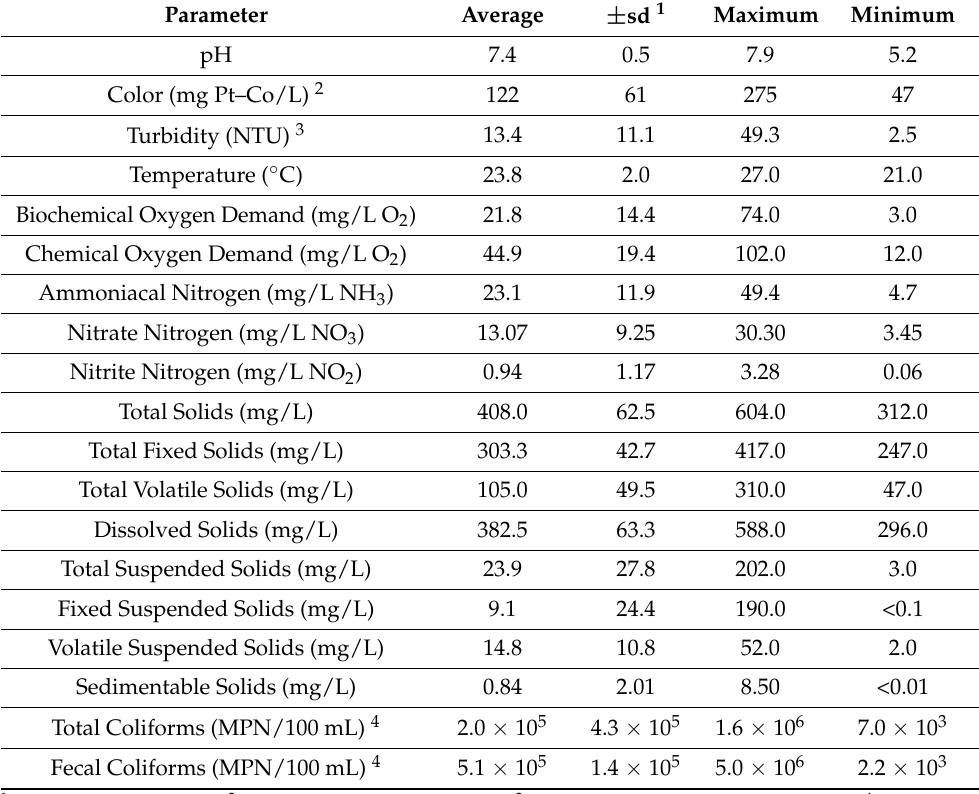
Table 2. Physicochemical and microbiological characterization of the treated effluent.